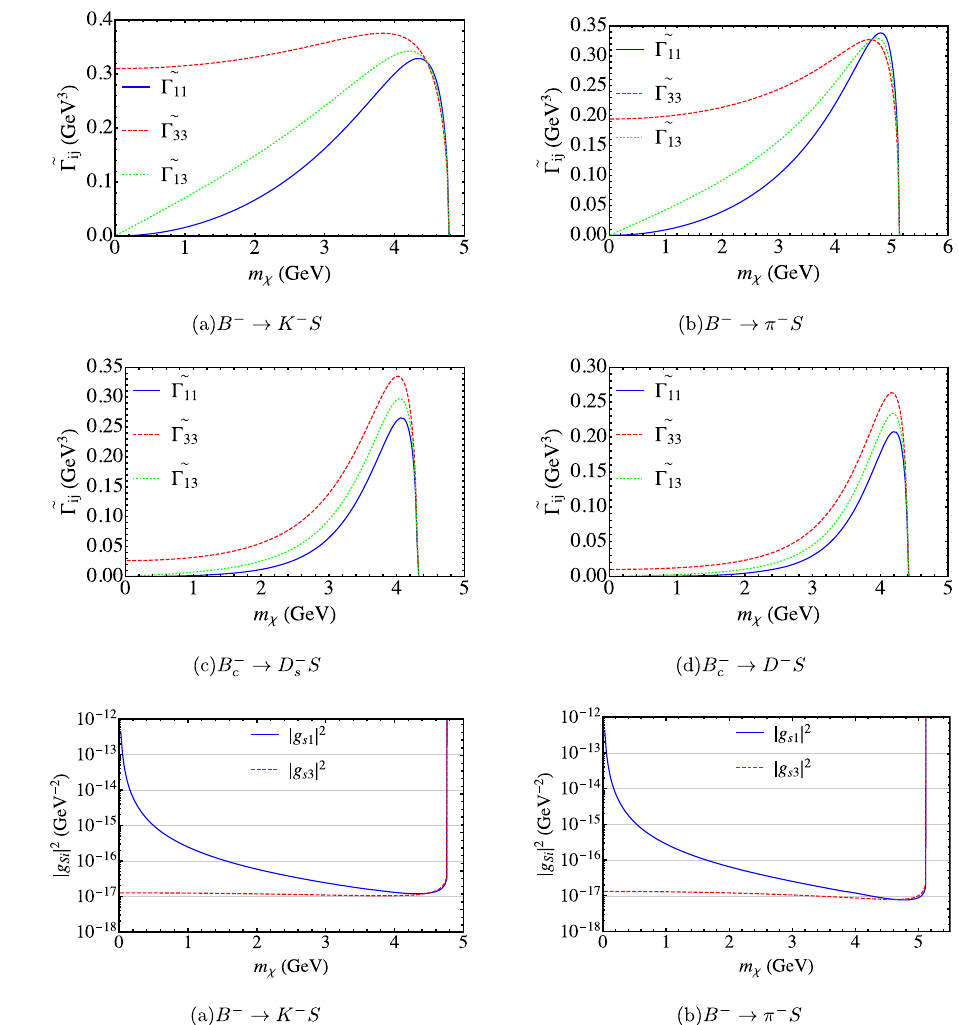
Fig. 2 (cid:6) (cid:8) ij s in B and B c meson 0 − → 0 − decays with invisible scalar